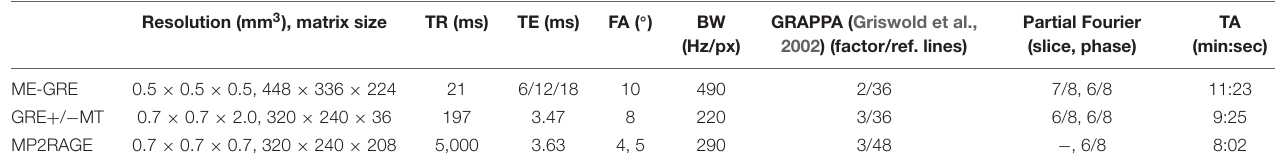
TABLE 1 | Sequence parameters including voxel size, matrix size, repetition time (TR), echo time (TE), flip angle (FA), bandwidth (BW), parallel imaging (GRAPPA), and partial Fourier specifics and acquisition time (TA). Resolution (mm 3 ), matrix size TR (ms) TE (ms) FA ( ◦ ) BW